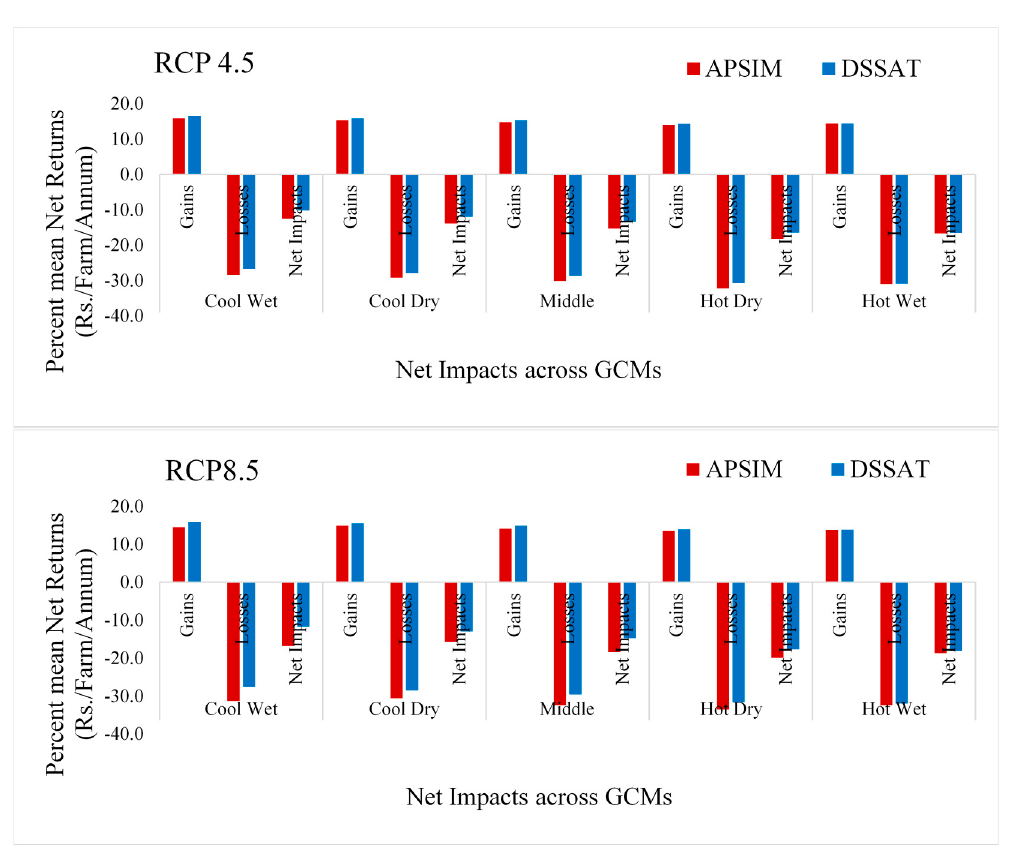
Figure 3. Climate change impacts on the current integrated agricultural production system. Table 6. Climate change impact on socio-economic factors in aggregate data for RCP 4.5. CM GCM Vulnerable Farm Household (%)